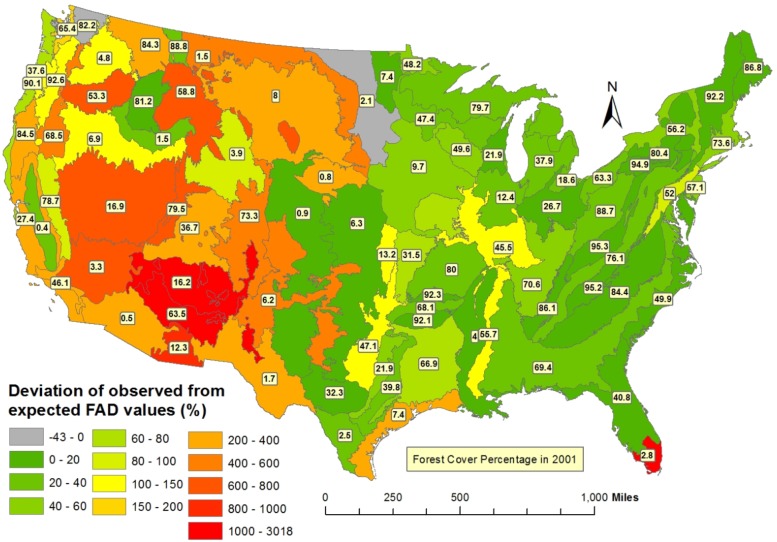
Deviation of observed from expected FAD values (%).Yellow labels depict percentage forest cover in 2001. High deviation values concentrate in Pacific Northwest ecoregions and the Southwest coast suggesting more severe clustering of forest losses and attrition around those regions.